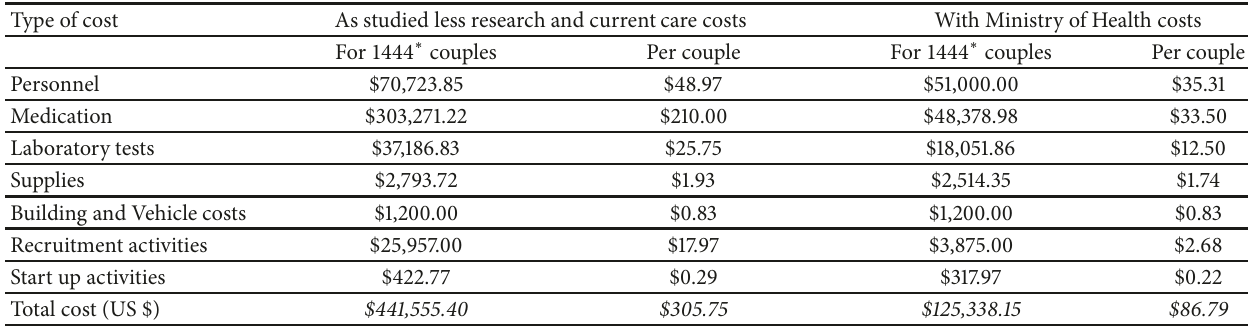
Figure 1: Proportion of costs related to each resource type of a program to deliver integrated PrEP and ART to HIV serodiscordant couples. The personnel cost is the salary for personnel providing service, recruitment activities include costs of activities that helped identify HIV serodiscordant couples and brought them to the study site including, information, education, and communication (IEC) material and support supervision visits to HIV testing and counselling staff to encourage couple testing in order to identify HIV serodiscordant couples, start up: costs associated with training and development of standard operating procedures, building: cost of rent, laboratory: costs of performing tests for PrEP delivery, including HIV and creatinine tests, medication: costs of PrEP and ART; supplies: costs of office stationery and clinical consumables. Table 3: Annual incremental cost of adding a PrEP component for HIV uninfected partners in HIV serodiscordant relationships to the current ART